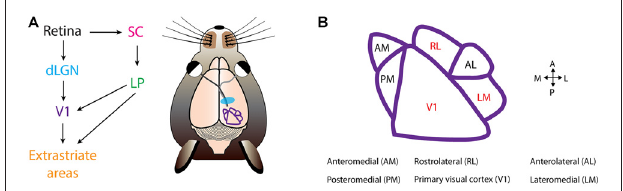
FIGURE 2 | Mouse visual cortex organization. (A) The first step of visual processing occurs in the retina. The retina conveys visual information to the dorsal lateral geniculate nucleus (dLGN). From dLGN, information is transfered to primary visual cortex (V1), and from V1 information diverges, and is directed to extrastriate areas. In mice, another prominent pathway is from the retina to the superior colliculus (SC), and from SC further to the lateral posterior nucleus (LP), and LP finally projects into V1 and extrastriate areas. (B) Extrastriate areas receiving V1 projections include: anteromedial (AM), posteromedial (PM), rostrolateral (RL), anterolateral (AL) and lateromedial (LM). Currently, PDS cells have been located in V1, RL and LM (colored in red). Visual cortical map is based on Andermann et al.